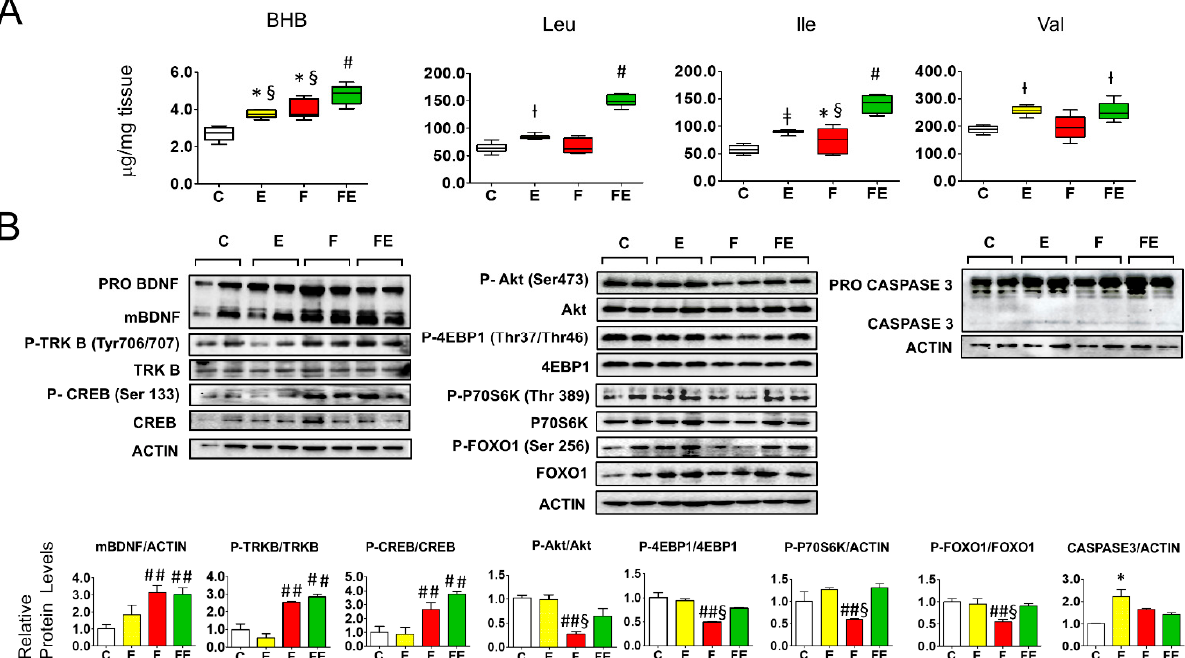
Figure 1. Association of beta hydroxy butyrate and branched-chain amino acids with BDNF-Akt- mTOR-FOXO1 signaling in gastrocnemius muscle of fasted rats undergoing mild endurance exercise. ( A ): Mass Spectrometry analysis of gastrocnemius muscle levels of BHB, Leu, Ile, and Val; ( B ): Western immunoblot analysis of gastrocnemius muscle proteins involved in BDNF-mTOR signaling, with quantified data shown below. Of note: P70S6K phosphorylation versus Actin ratios are depicted, the ratio with the non-phosphorylated protein did not vary. ( A , B ): Analysis was carried out comparing control rats with rats subjected to exercise, fasting, or fasting with exercise. ( N = 4, n = 3). One way ANOVA was carried out followed by a Newman Keuls post-hoc test. * p < 0.05 vs. C, † p < 0.05 vs. C and F, ‡ p < 0.05 vs. C, F and FE, # p < 0.05 vs. E, F, and C, ## p < 0.05 vs. E and C, § p < 0.05 vs.